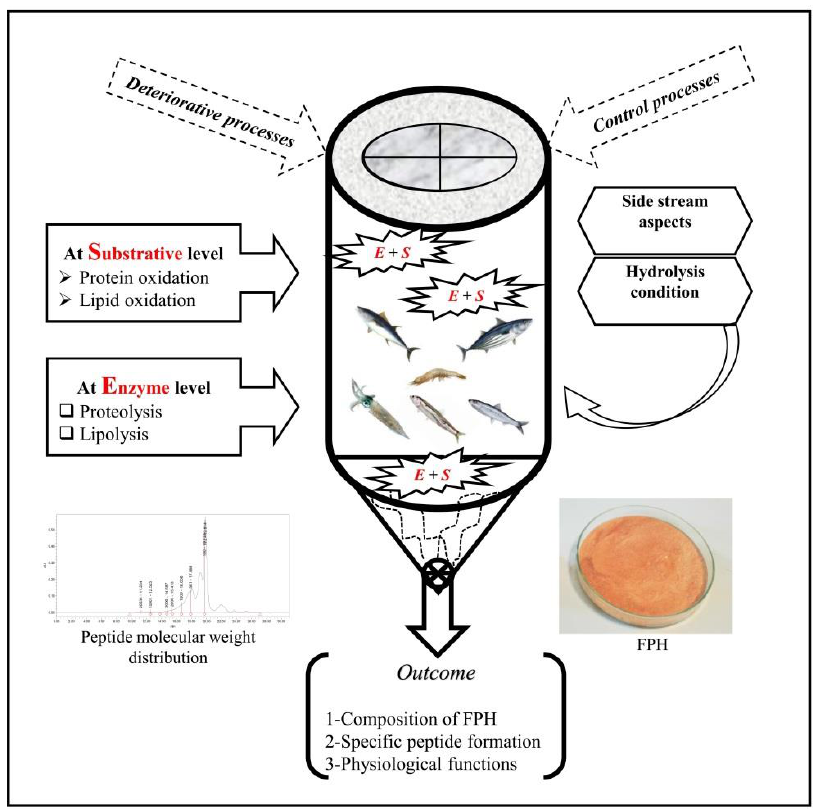
Figure 2. Main oxidative processes, control measures, and properties of FPH from byproducts of the seafood industry.